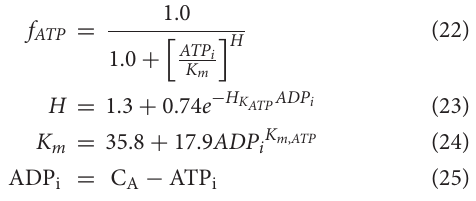
FIGURE 6 | Analysis of the ion transfer function (I–V relationship) for a 2-pore K + current in human chondrocytes. (A) Raw experimental data plotted as an I–V curve together with a superimposed I–V relationship (red trace) based on the mathematical formulation given in the text. These results were obtained in isotonic [K + ]o conditions. The two traces in (B) show corresponding I–V relationships derived using the Eisenman Principle, so that this K + current can be studied in conditions ([K + ]o of 5mM and 15mM) that are in the physiological range. The blue trace shows the I–V relationship for this 2-pore K + channel when [K + ]o is 15mM. The black trace shows the change in this ion transfer relationship when [K + ]o is decreased to 5mM. (see Table 1 and section